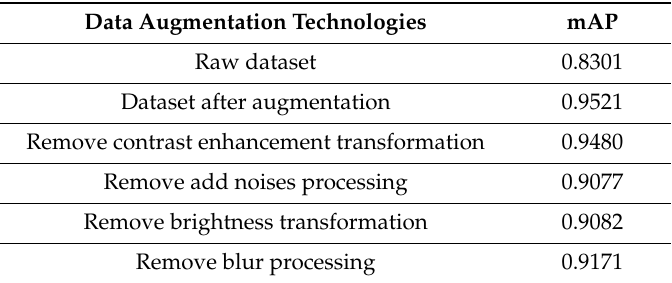
Table 8. mAP results for various situations.